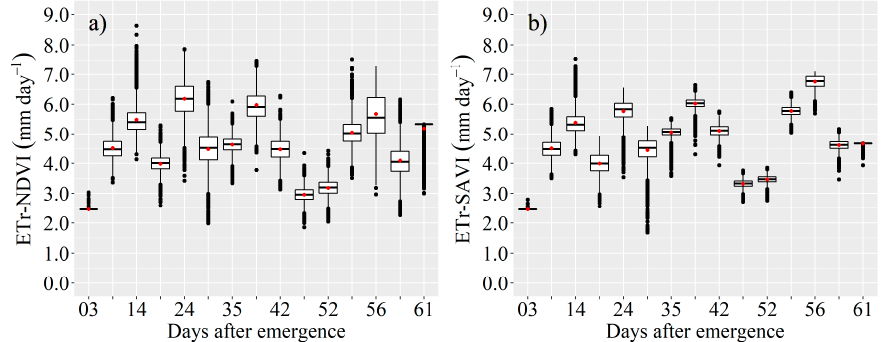
Figure 9. Descriptive statistics of actual evapotranspiration of the crop using the models derived from the NDVI ( a ) and SAVI ( b ).